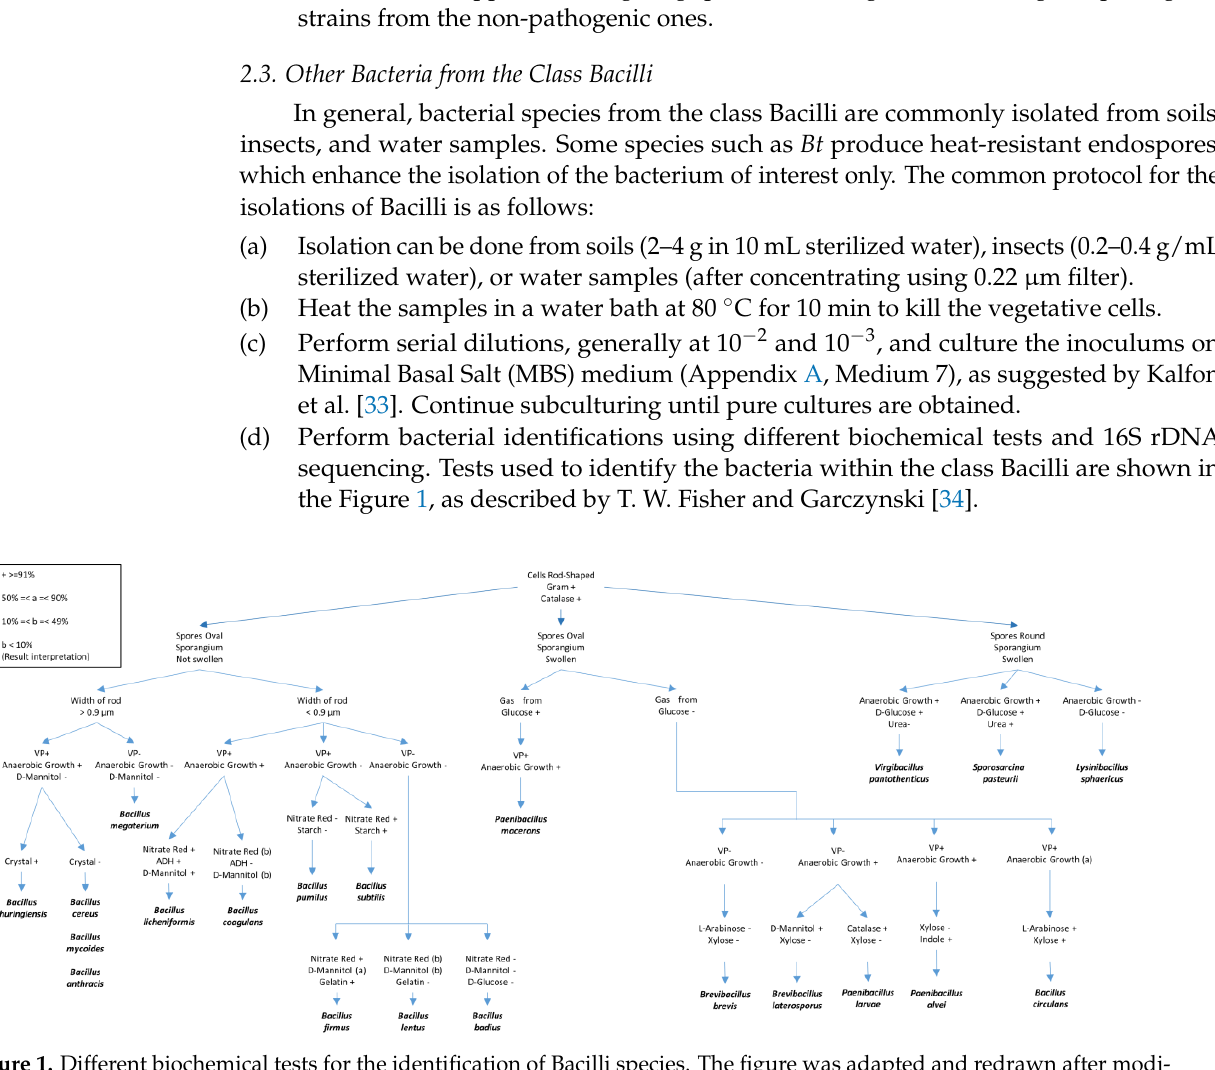
Figure 1. Different biochemical tests for the identification of Bacilli species. The figure was adapted and redrawn after modi- fications from T.W. Fisher and Garczynski [23]. Some details of the tests presented include VP (Voges–Proskauer test (Barritt’s method)), Gelatin (proteolysis of gelatin), ADH (presence of the amino acid arginine dihydrolase), Glucose (fermentation) and Mannitol (fermentation); Starch (hydrolysis), Nitrate (nitrate reduction to nitrite), and Urea (Urease test).